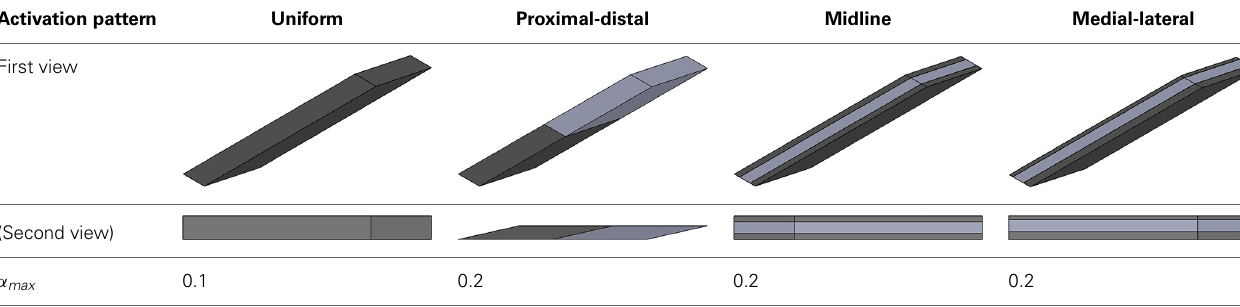
Table 1 | Level and regionalization of activation in different simulations. Activation pattern